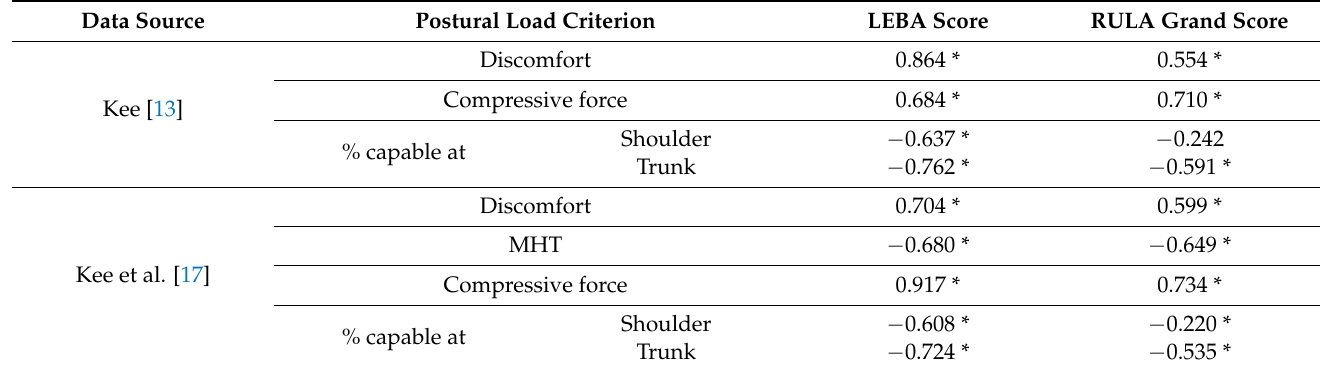
Table 3. Correlation coefficients between the LEBA and RULA grand scores and the postural load